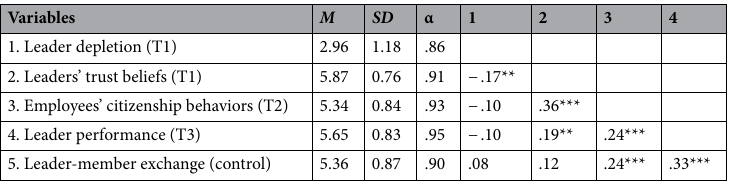
Table 3. Means, standard deviations, and intercorrelations (Study 2). T1 time 1, T2 time 2, T3 time 3. * p < .05. ** p < .01. *** p < .001.